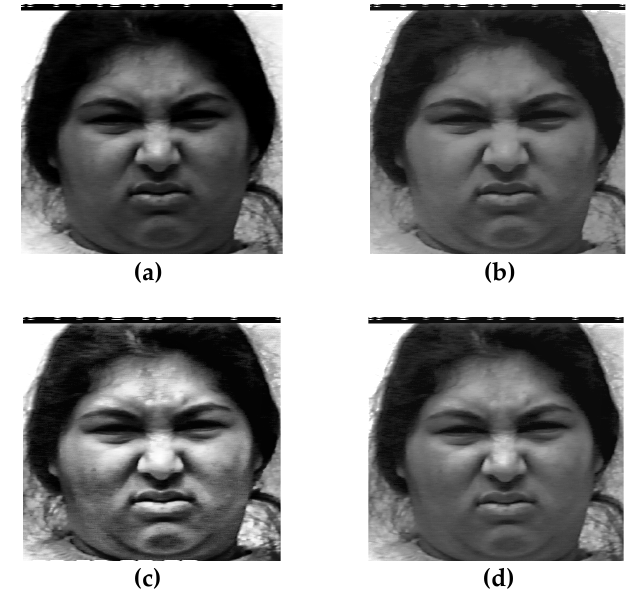
Figure 6. The result obtained using different algorithms on the CK+ database: (a) original image, (b) HE, (c) AHE, and (d) CLAHE .